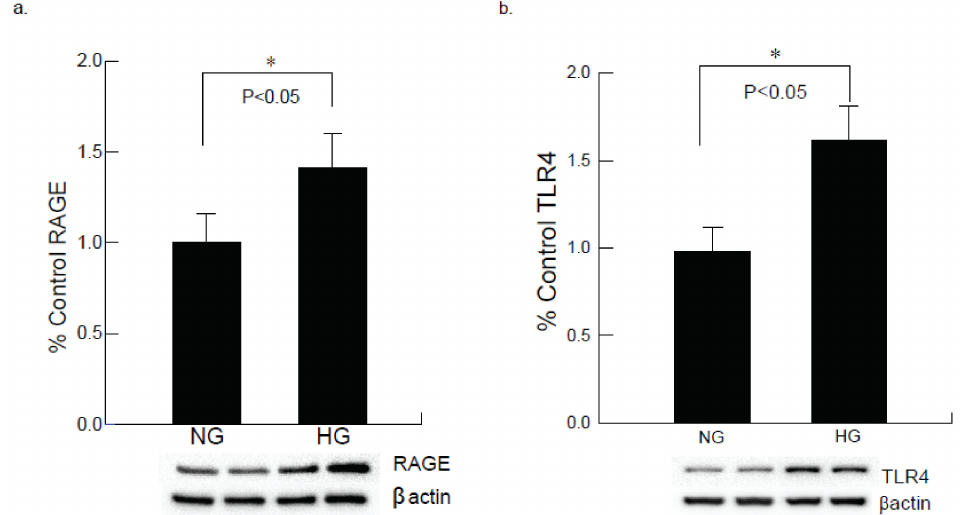
Figure 5. Hyperglycemic exposure exhibits altered levels of RAGE and TLR4 in AC-16 cardiomy- ocytes. ( a ) Increased RAGE expression was observed under the hyperglycemic condition in car- diomyocytes compared to normo-glycemic condition (* p < 0.05). ( b ) Western blot analysis of AC16 cardiomyocytes under hyperglycemic conditions for 24 h showed a statistically significant increase in the expression of TLR4 as compared to cells exposed to normal glucose (* p <